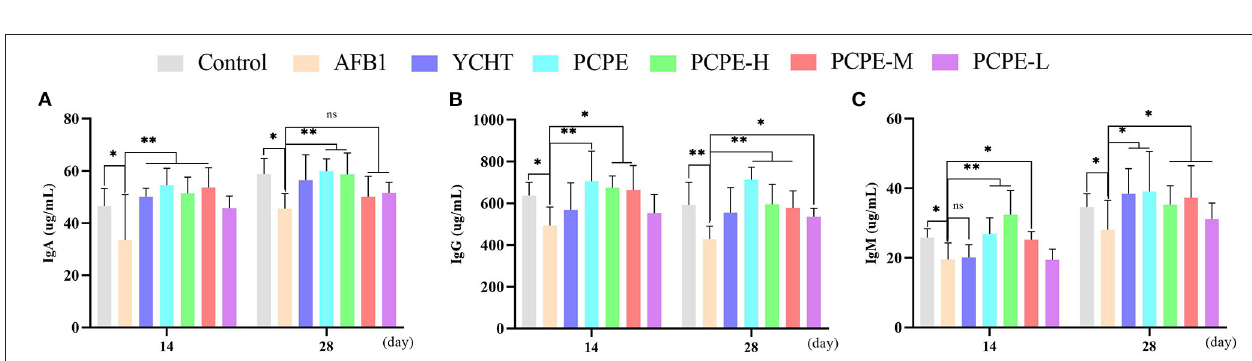
FIGURE 4 | Effect of PCPE on mRNA expressions of apoptosis-genes in liver of Broilers. The mRNA expressions levels of apoptosis-genes were identified by real-time PCR. All data were expressed as mean ± SD. Asterisk means significant difference ( p < 0.05) compared to the control and AFB1 group. (A) Bcl-2; (B) Caspase-3; (C) Caspase-9; (D) P53; (E) Bak; (F) Bax.